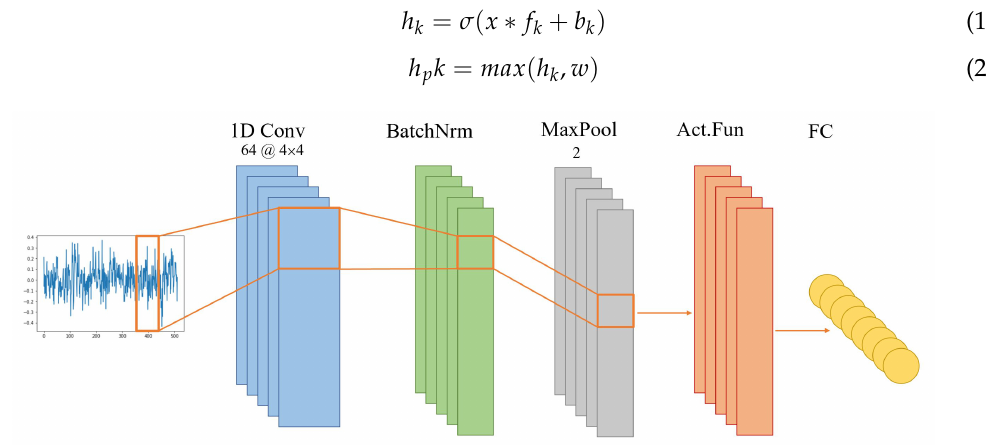
Figure 3. A schematic representation of the major CNN